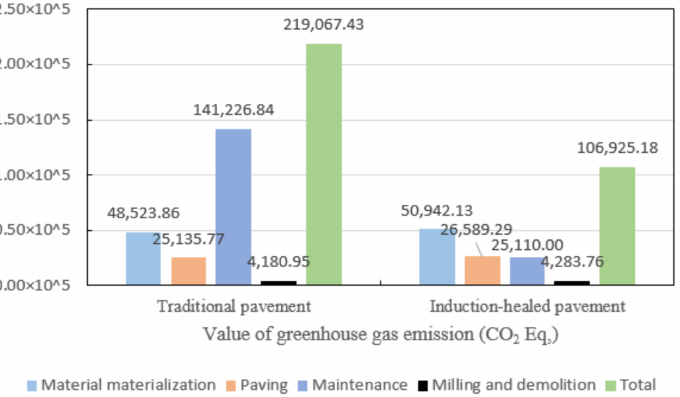
Figure 15. Greenhouse gas emissions of two asphalt pavements in their whole life